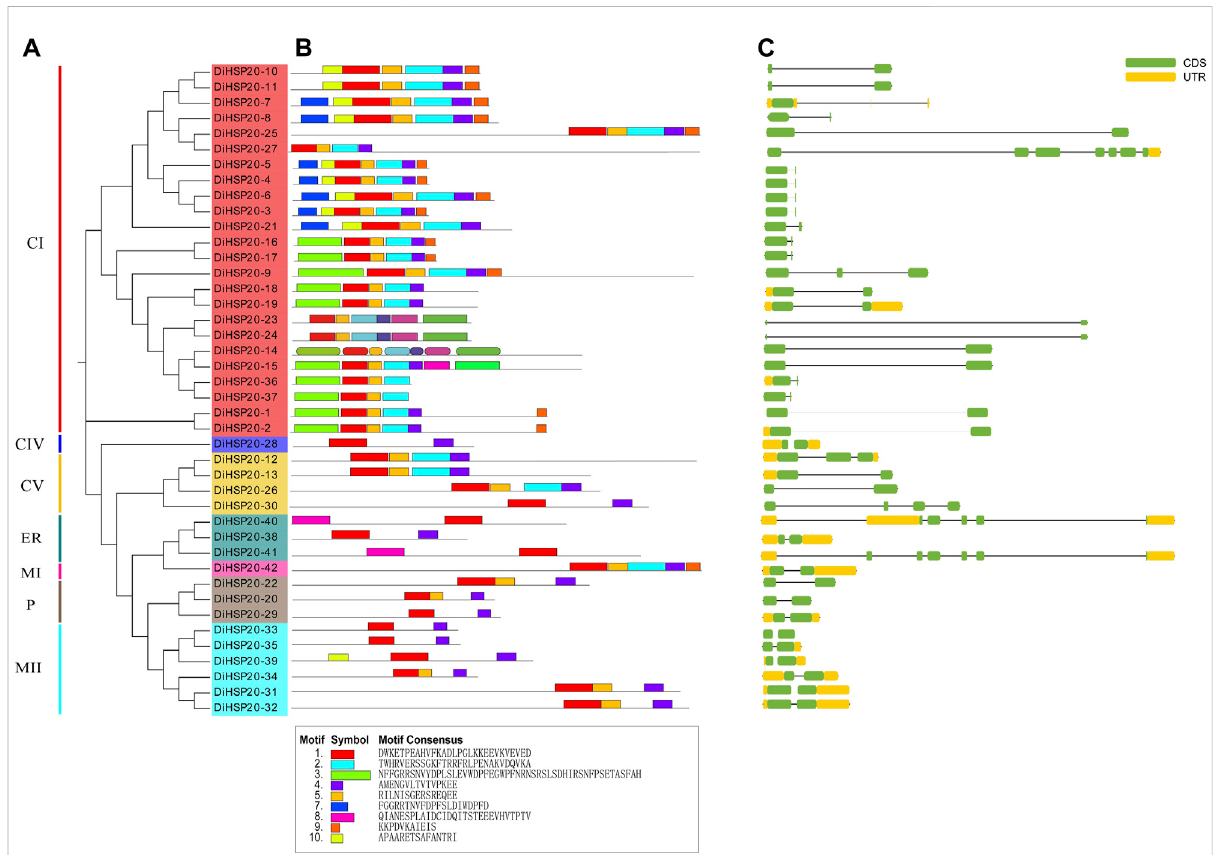
FIGURE 2 Members ofthe DiHSP20 family ’ sphylogeneticconnections,structures, and motifs (A) Maximum Likelihoodtechniqueswereused to generate a phylogenetic tree comprising 42 DiHSP20 proteins. Different backdrop colors and letters are used to denote the different groupings (B) DiHSP20 proteins ’ conserved motifs. Different motifs are represented by colored boxes and different numbers (C) The DiHSP20 genes ’ exon/intron architecture. Green boxes, black lines, and yellow boxes correspondingly indicate exons, introns, and UTRs. With the help of TBtools, we were able to estimate the phylogenetic tree, conserved motifs, and gene